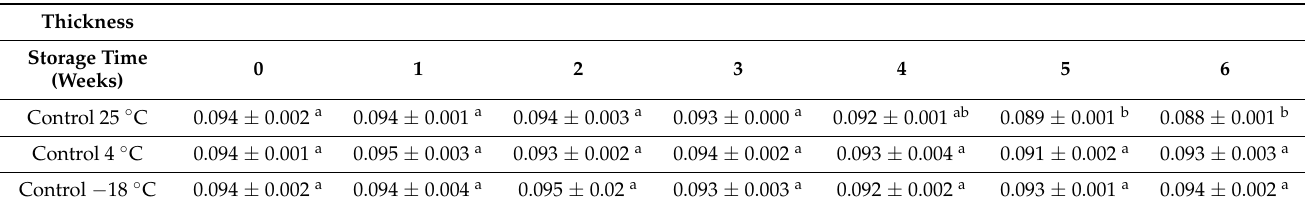
Table 1. Film thickness (mm) of SPI edible films stored at different temperatures (25 ◦ C, 4 ◦ C and − 18 ◦ C).